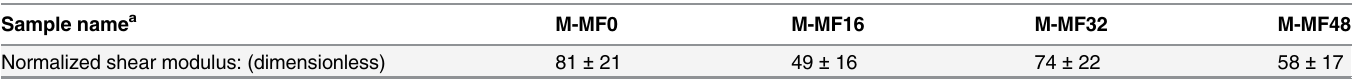
Table 2. Normalized shear modulus (Eq 2) of different magnetic tissue substitutes. G control = 101 ± 10 Pa represents the mean value for control sam- ples without particles (Ctrl-MF0 to Ctrl-MF48). Uncertainties were estimated according to theory of error